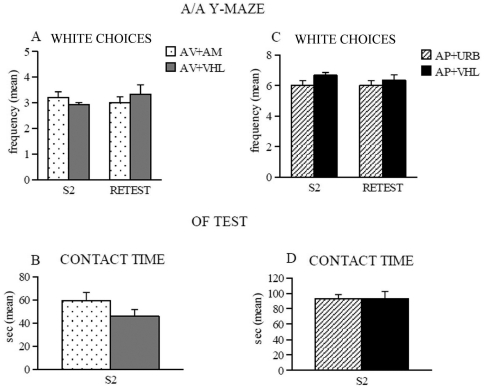
Behavioral responses of avoiding (AV) and approaching (AP) mice in A/A Y-Maze and OF.On the left side, the responses of AV animals treated with AM251 (AM) or vehicle (VHL) in A/A Y-Maze (A) and OF test (B). In A/A Y-Maze, AV+AM animals maintained the number of white choices and in the OF test they explored the environment and contacted the object not differently than AV+VHL animals. On the right side, the responses of AP animals treated with URB597 (URB) or vehicle (VHL) in A/A Y-Maze (C) and OF test (D). In A/A Y-Maze, AP+URB animals did not change the number of white choices and in the OF test they were active as AP+VHL animals in exploring the environment and contacting the object. Abbreviations: S2: second session; retest: retest session.